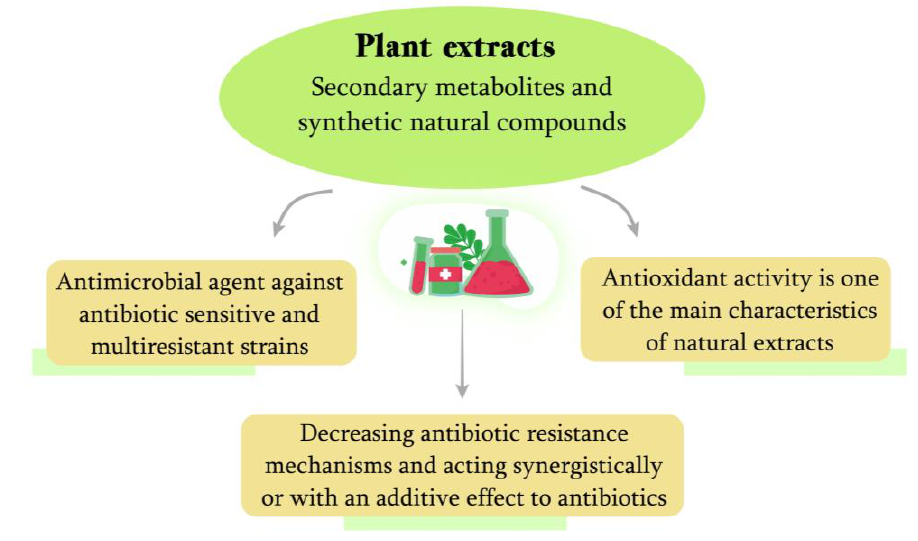
Figure 2. Biological activities of plant extracts.